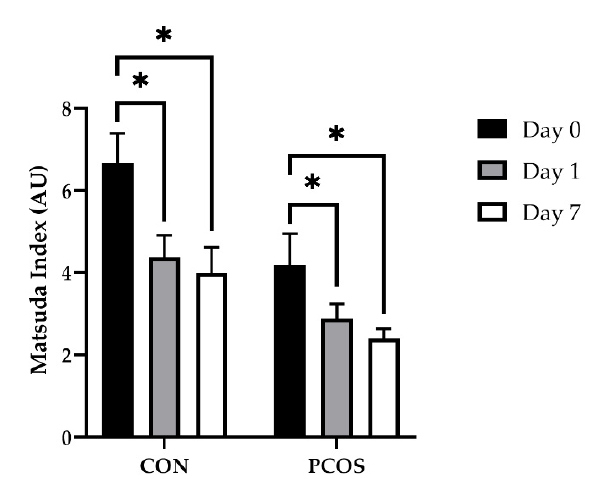
Figure 6. Matsuda index mean values ( ± SE) in CON ( n = 15) and PCOS ( n = 14). * = significance between days, p < 0.05. CON = non-PCOS women; PCOS = women with polycystic ovarian syn- drome.